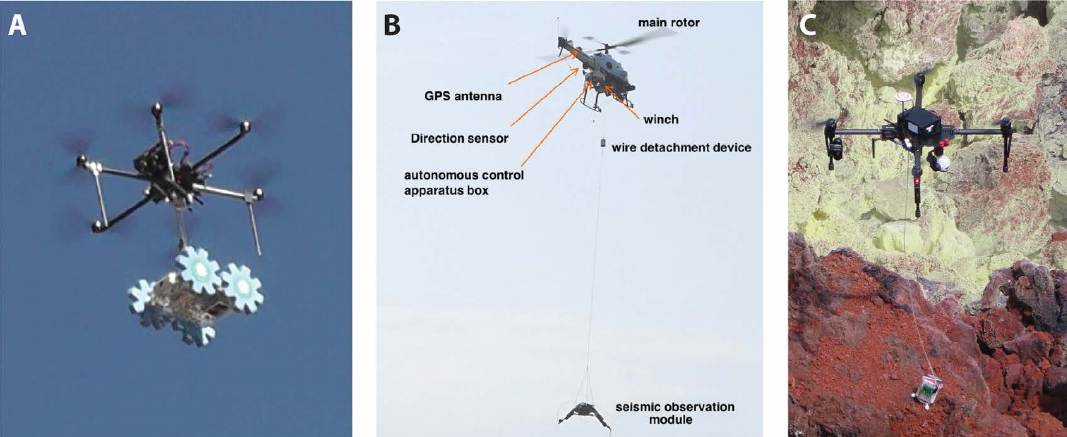
Figure 19: Instrument deployments. [A] A small mobile robot (‘CLOVER’, <3 kg and <0.5 m long) for ground- based sampling and observation being transported by a ZionPro800 hexa-rotor at Mt. Asama, during operational tests [Nagatani et al. 2014]. [B] Deployment of a 5-kg seismic observation module slung under a RMAX-G1 single- rotor vehicle at Kuchinoerabujima, Japan, 2015 (adapted from Ohminato et al. [2017]). [C] A sensor pod being deployed on Tavurvur, Papua New Guinea, (2018) using a quadrotor. The pod measures surface